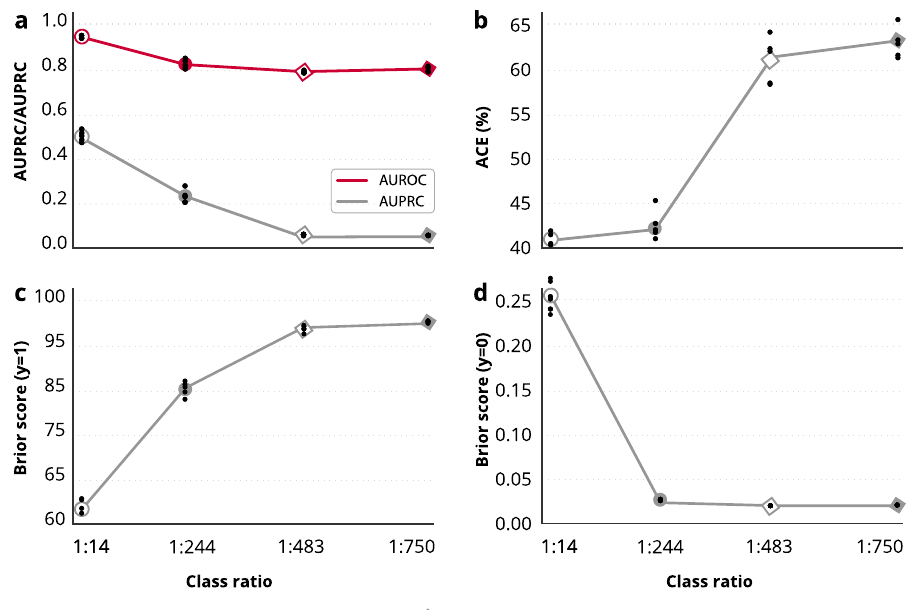
Fig. 3 Relationship between the class ratio and evaluation results. The fi gure shows the mean values (circle or diamond) and individual cross-validation values (dots) for the best within-class MLRP model for each framing structures. a AUPRC (gray) and AUROC (red) discrimination results; ( b ) ACE; ( c ) The strati fi ed Brier score for the positive class; ( d ) The strati fi ed Brier score for negative class. AUPRC area under the precision recall curve, AUROC area under the receiver operating characteristics curve, ACE average calibration error. Table 3. Missing values for vital sign parameters. Parameter Fixed time Sliding Sliding to onset (%) window (%) window w. D.I